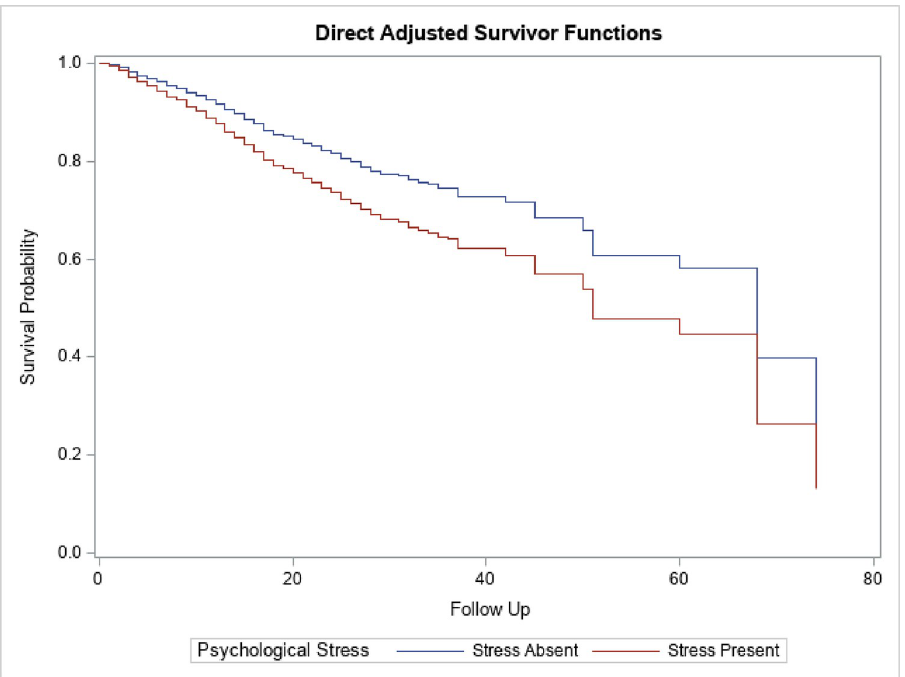
Fig 2. Cox-Proportional Hazard model stratified by symptoms of psychological stress. Median (Q1, Q3) survival time among the population with psychological stress was 32 years (17 years, 50 years) while median survival time among those without psychological stress was 60 years (32 years, 68 years) The regression model was adjusted for age, race/ethnicity, educational attainment, marital status, poverty income ratio, health coverage, delayed appointment, usual place of care, affordable care, and year of